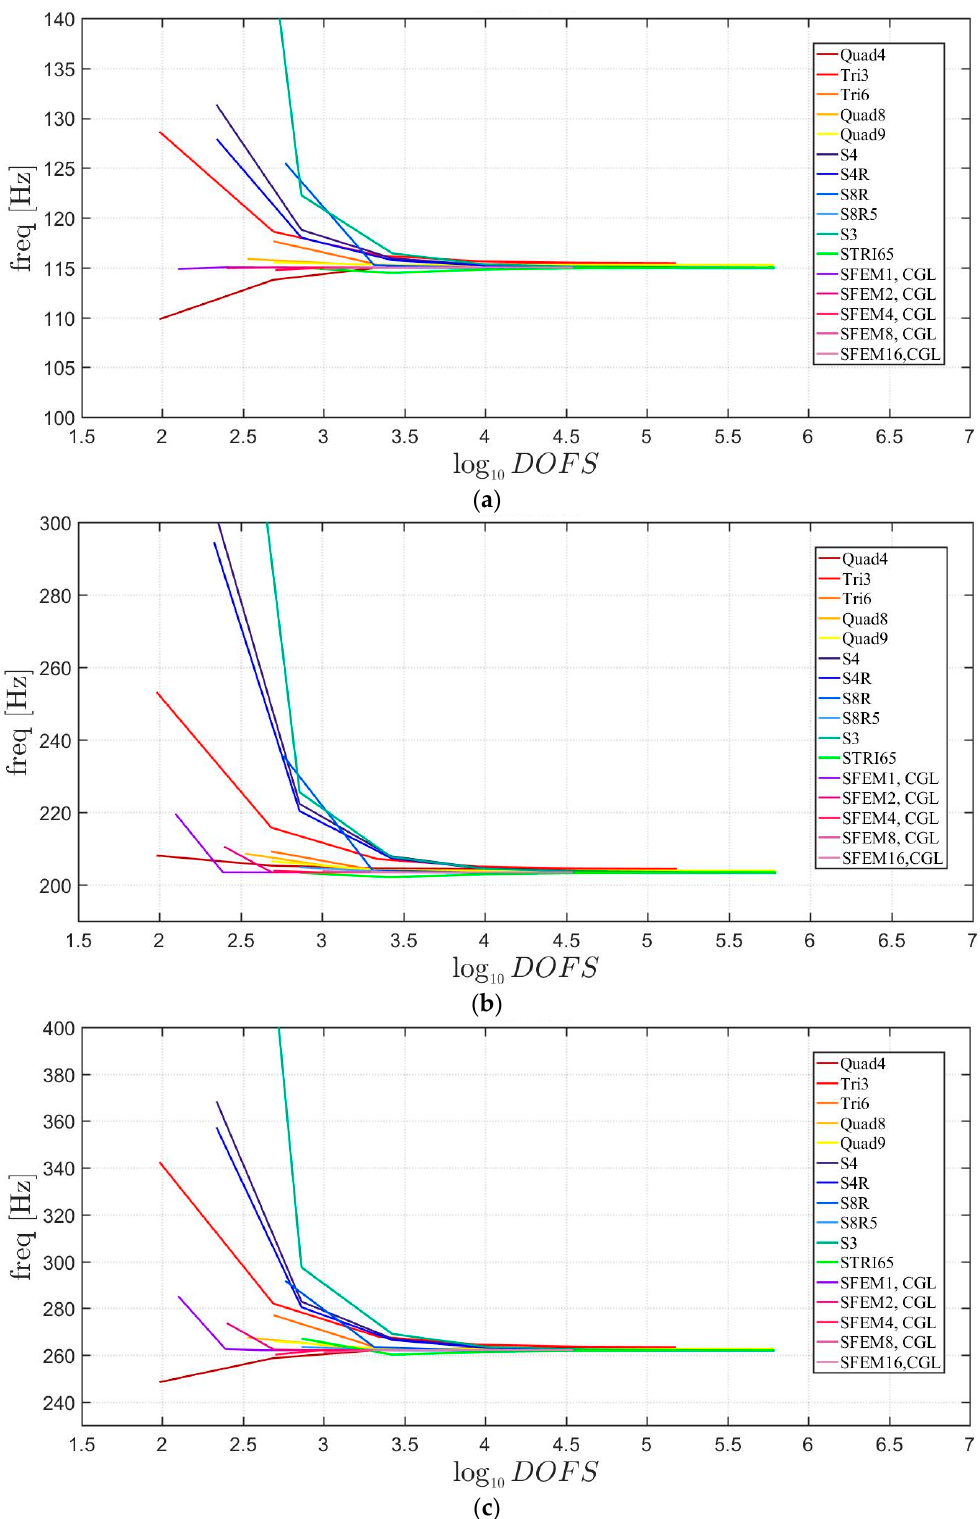
Figure 3. First three natural frequencies an isotropic skew plate of 30°: ( a ) First frequency; ( b ) Second frequency; ( c ) Third frequency.